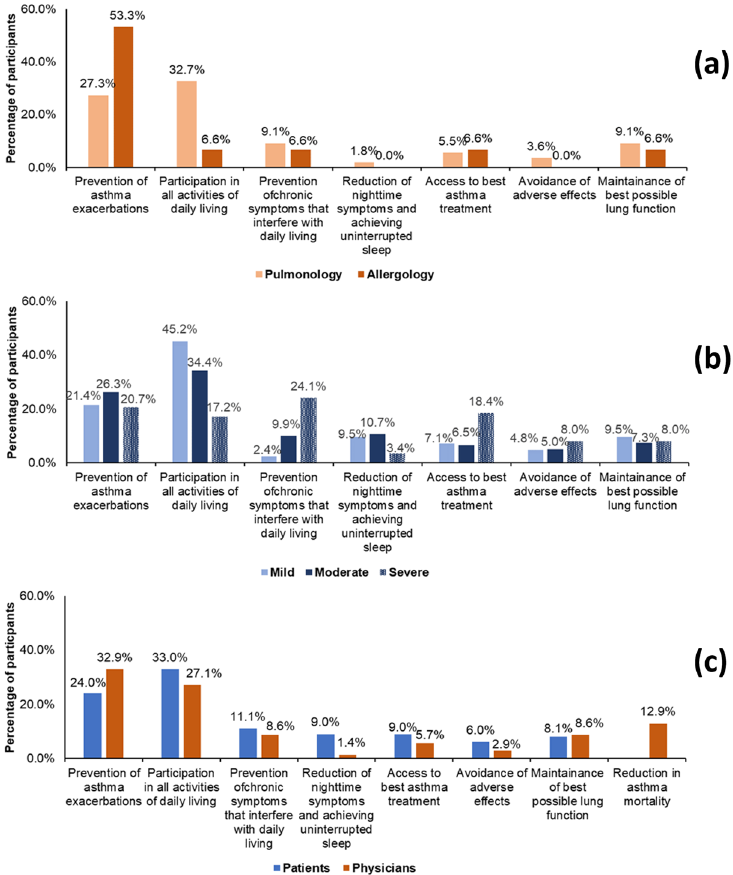
Figure 1. Valuation of treatment goals in physicians according to their specialty ( a ), in patients according to asthma severity ( b ) and in physicians as compared to patients ( c ). “Reduction in asthma mortality” was not a treatment goal in patient questionnaire due to cultural reasons.